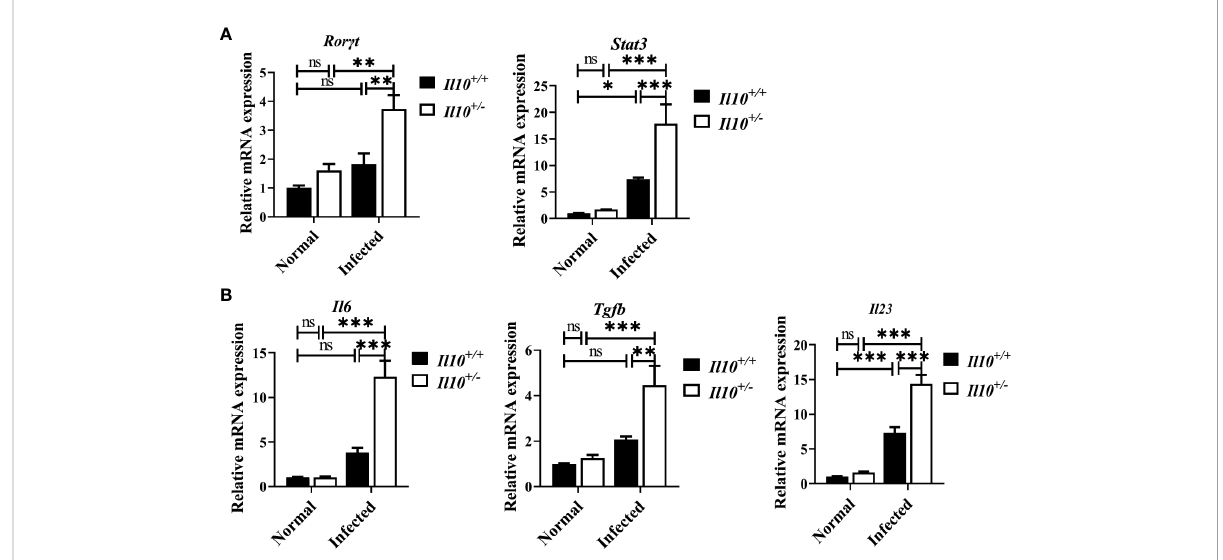
FIGURE 4 IL-10 de fi ciency promotes the transcriptional factors and associated cytokines of Th17 cells in clonorchiasis of Il10 +/- mice. (A) The expression levels of Ror g t mRNA and Stat3 mRNA. (B) The expression levels of Il6 , Tgfb , and Il23 mRNA in the liver were determined by quantitative RT- PCR. Compared with indicated group, * P < 0.05, ** P < 0.01, *** P < 0.001, ns, no signi fi cance.